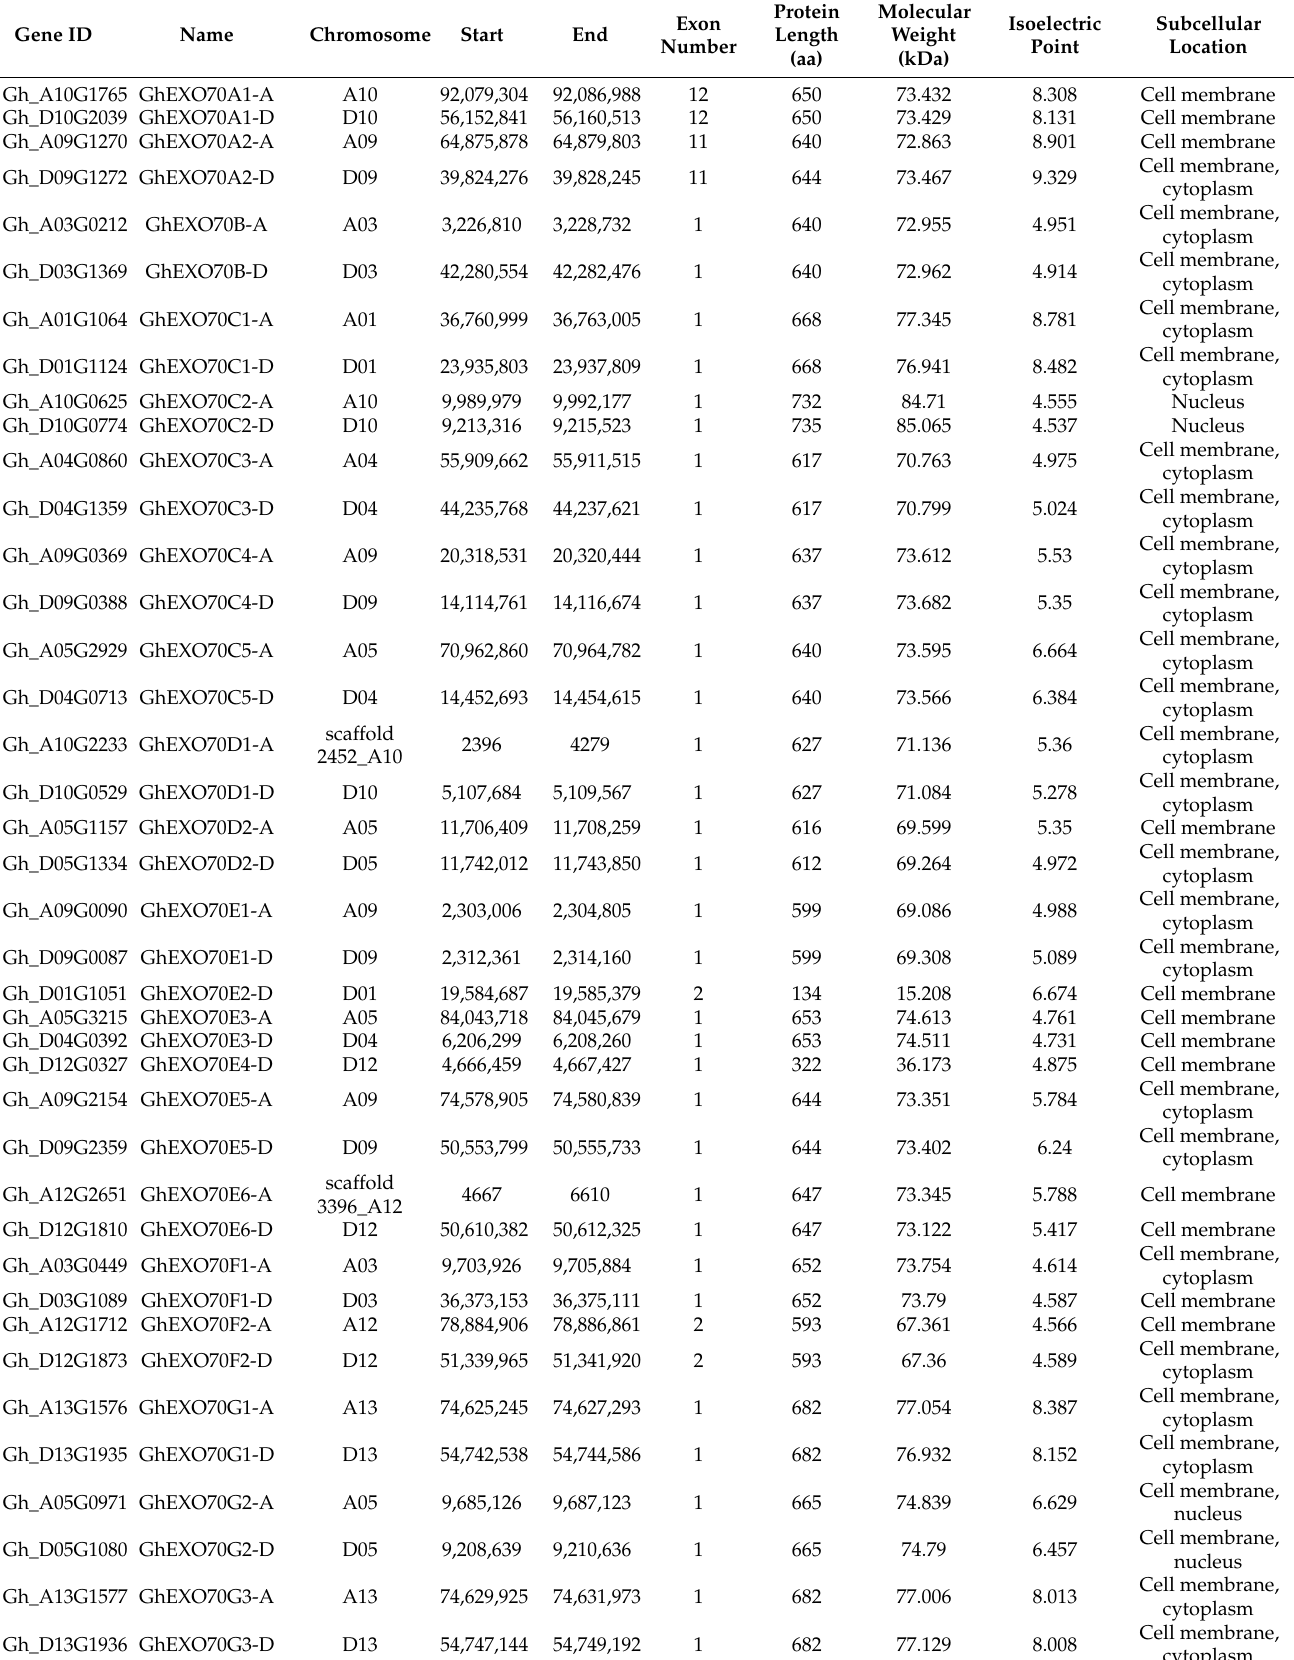
Table 1. Nomenclature and analysis of physicochemical properties of EXO70 family genes in G. hirsutum